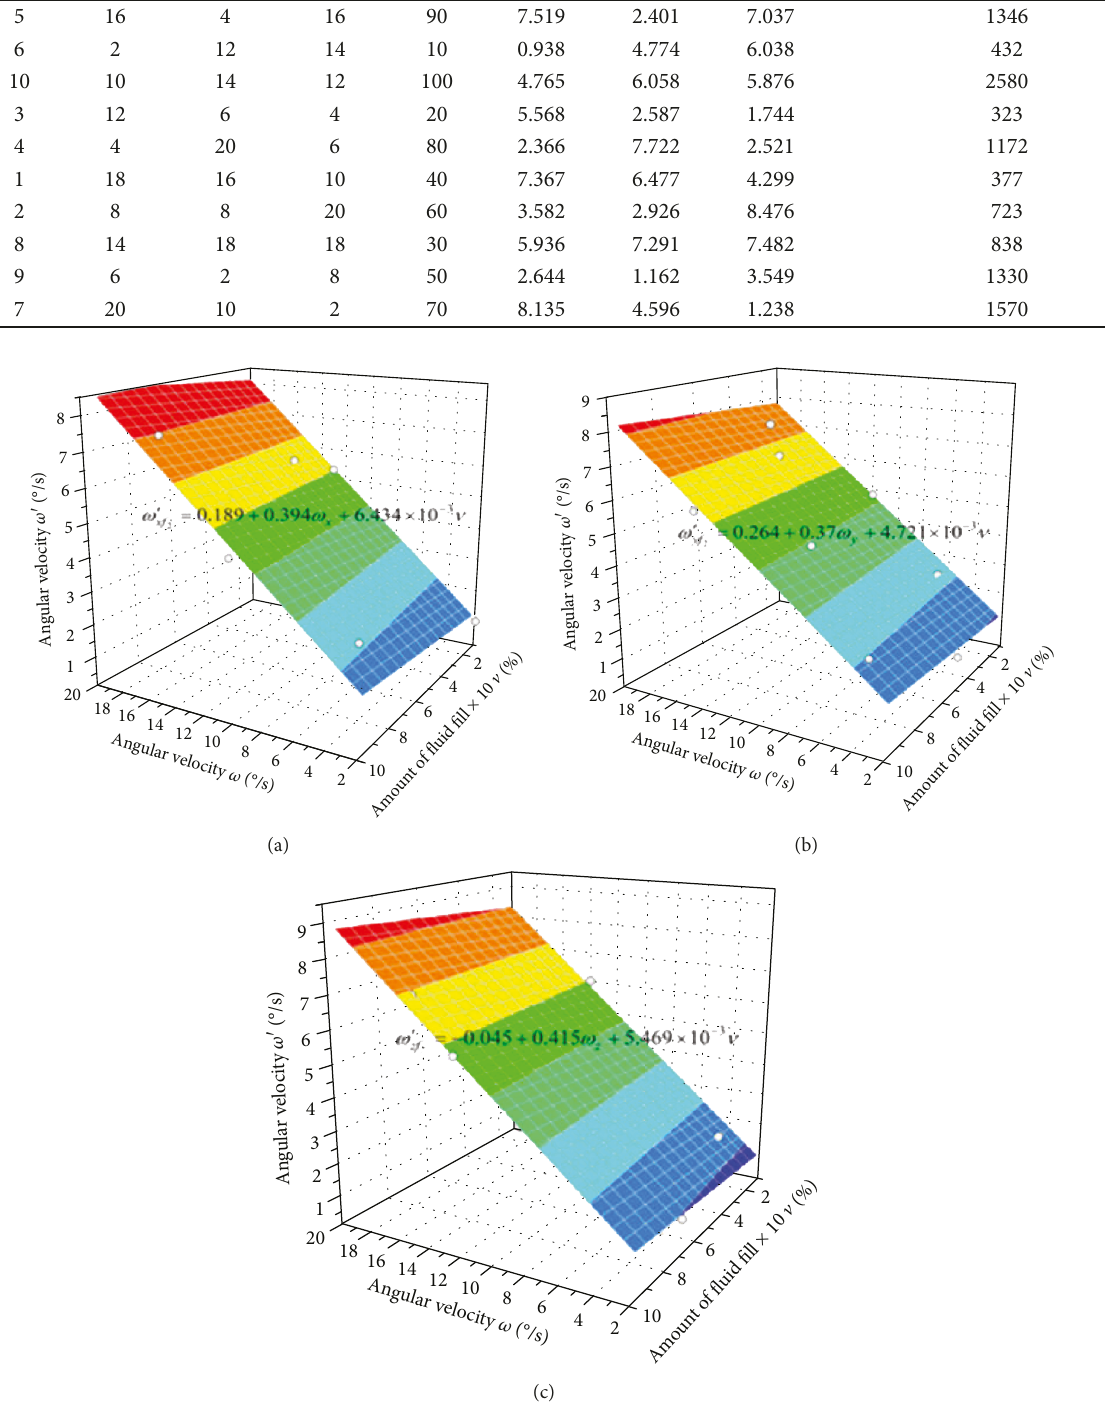
′ , (b) ω ′ , and (c) ω ′ xf 2 yf 2 zf 2